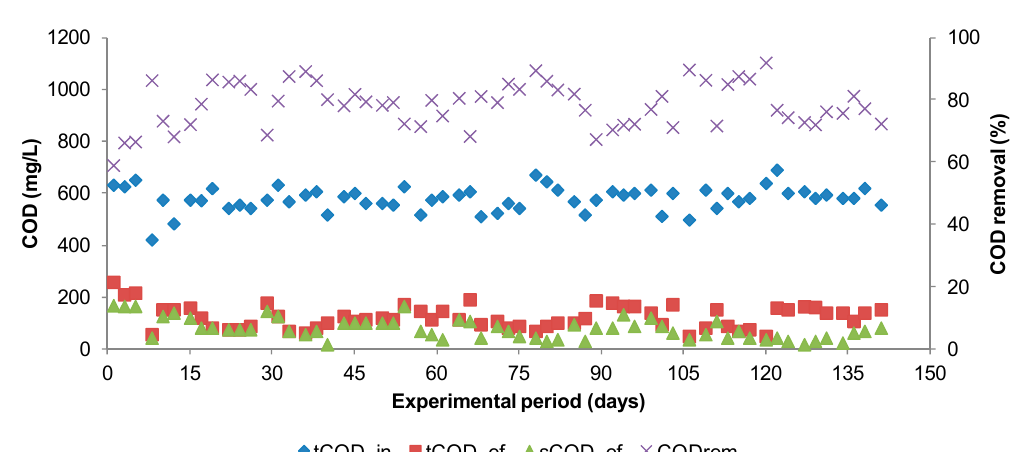
Figure 3. Chemical oxygen demand (COD) removal pattern in the immobilized cell biofilter treating diclofenac-based wastewater.